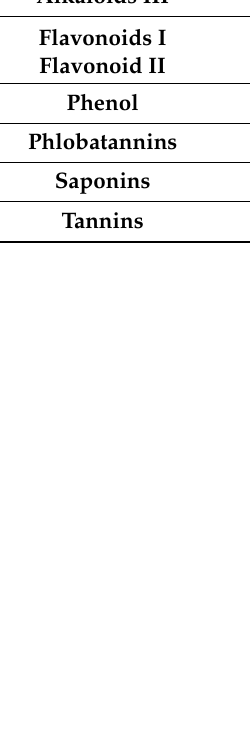
Table 2. Phytochemical screening of extracts from various parts of M. malabathricum L. Phytochemical Screening Leaves Stem Roots T1 T2 Alkaloids I